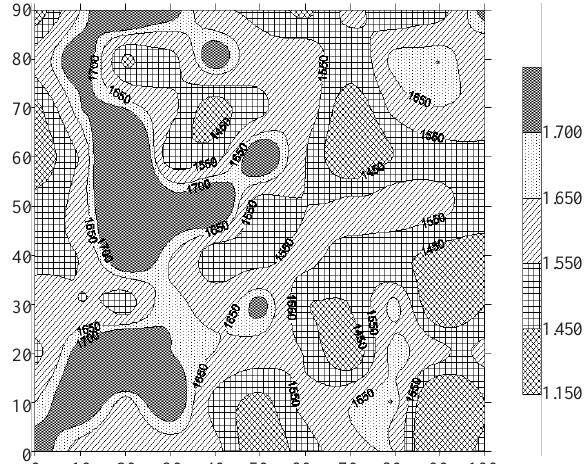
Figura 4. Mapa de produtividade de algodão (A6) em kg ha -1 – Votuporanga, 1996.